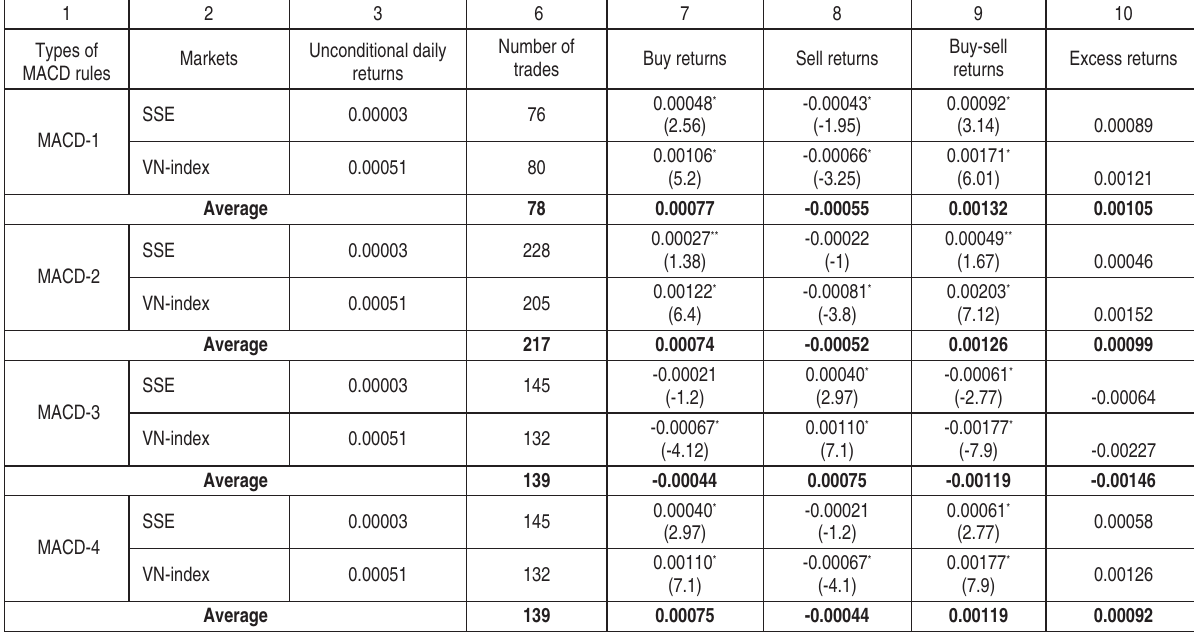
Table 5. Results of the four MACD trading strategies in the new fresh